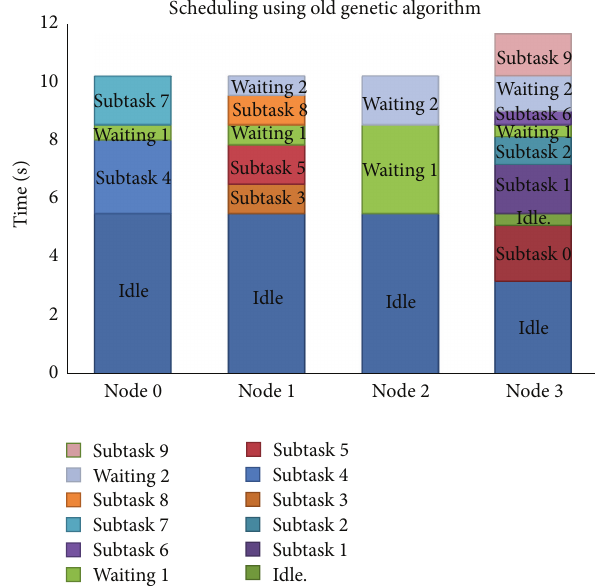
Figure 7: Detailed timewise schedule for all subtasks of DAG based task 𝑡 using genetic algorithm for DAG scheduling in grid.